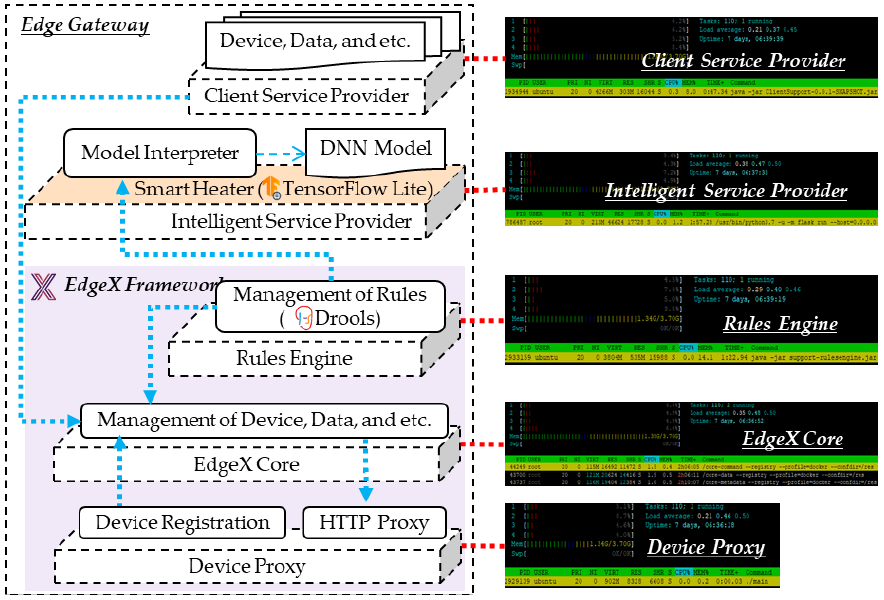
Figure 8. Implementation of the microservice providers run on edge gateway.